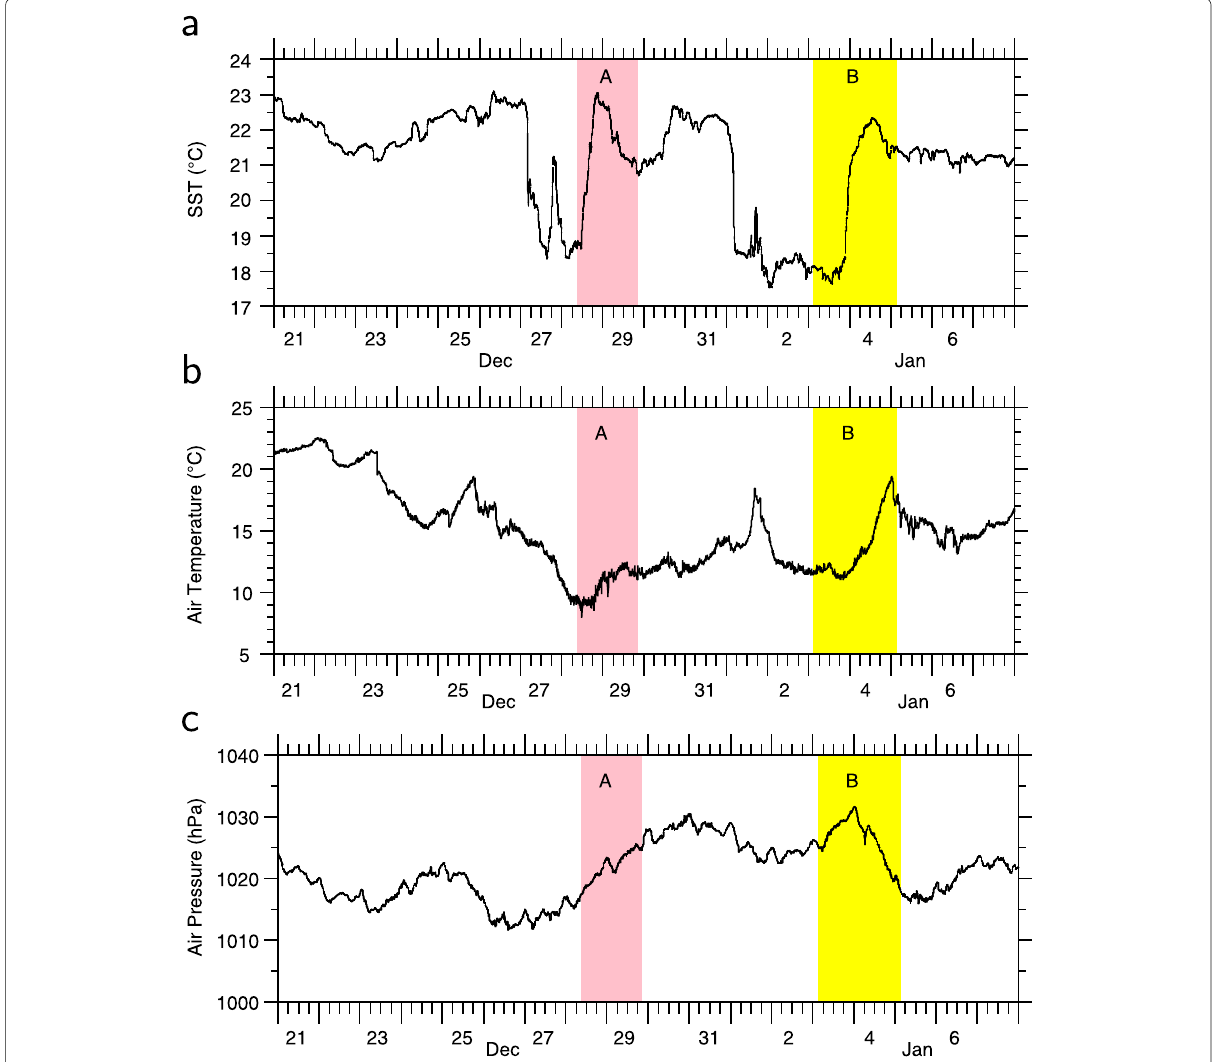
Fig. 4 Plots of Saildrone-observed a SST, b air temperature, and c air pressure with respect to time during the observation off the southern coast of Japan from December 21, 2018, to January 7, 2019. Periods of observations along the A and B tracks are indicated by pink and yellow